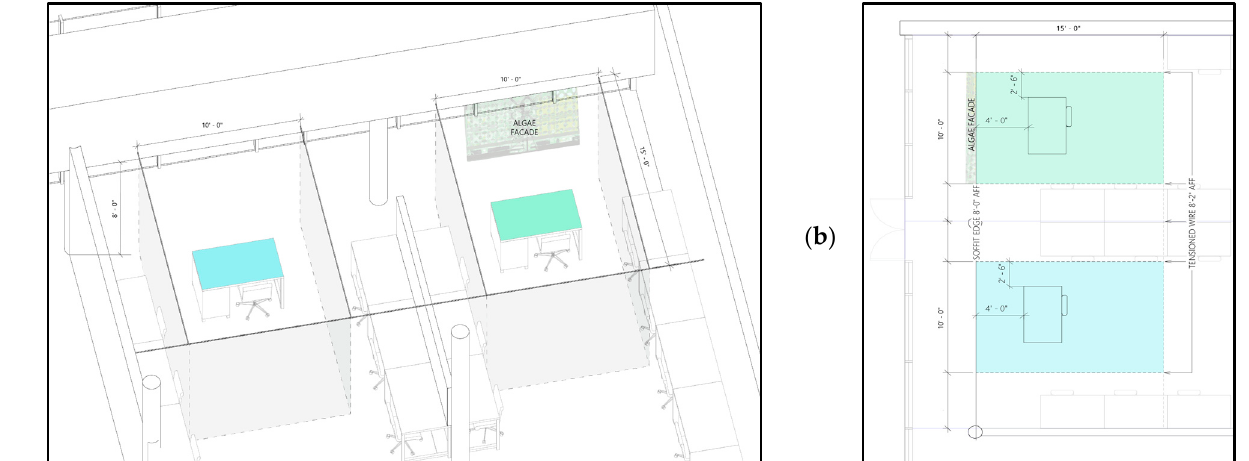
Figure 2. Representation of the experiment room setting: ( a ) axonometric representation and ( b ) plan representation.